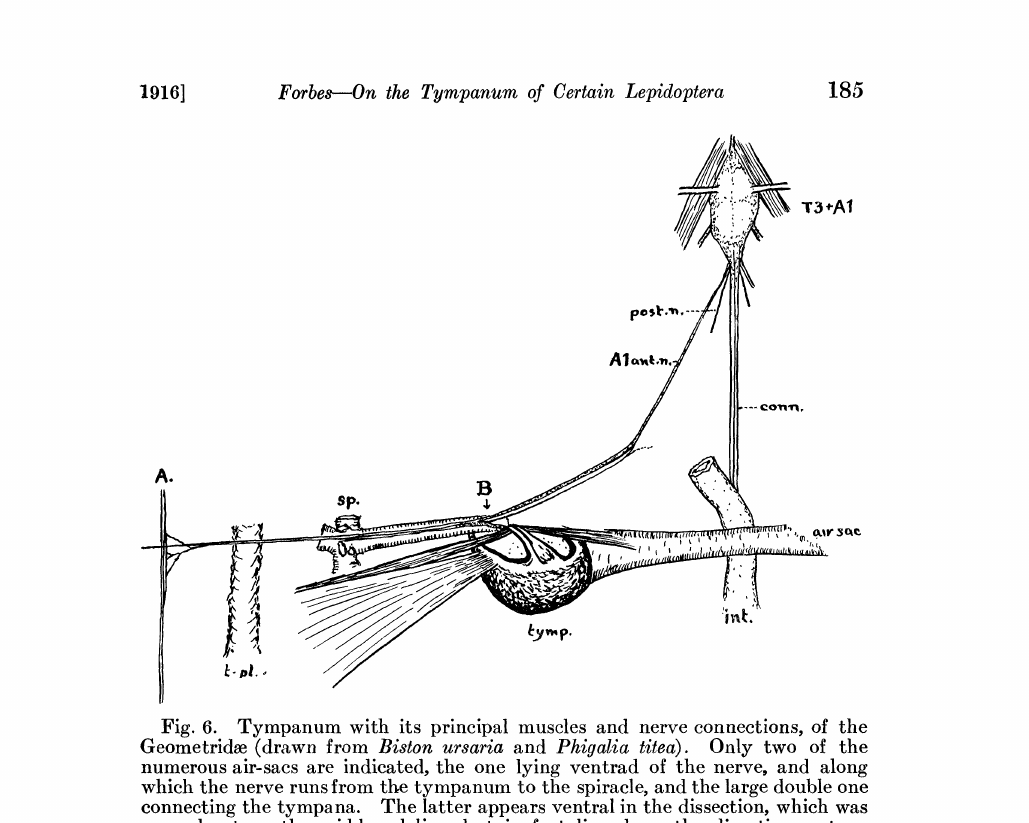
Fig. 6. Tympanum with its principal muscles and nerve connections, of the Geometride (drawn from Biston ursaria and Phigalia titea). Only two of the numerous air-sacs are indicated, the one lying ventrad of the nerve, and along which the nerve runs from tle tympanum to the spiracle, and the large double one connecting the tympana. The latter appears ventral in the dissection, which was opened out on the middorsal line, but in fact lies above the digestive system. When the dissection is first opened it is normally filled with air and may be the most conspicuous object in the